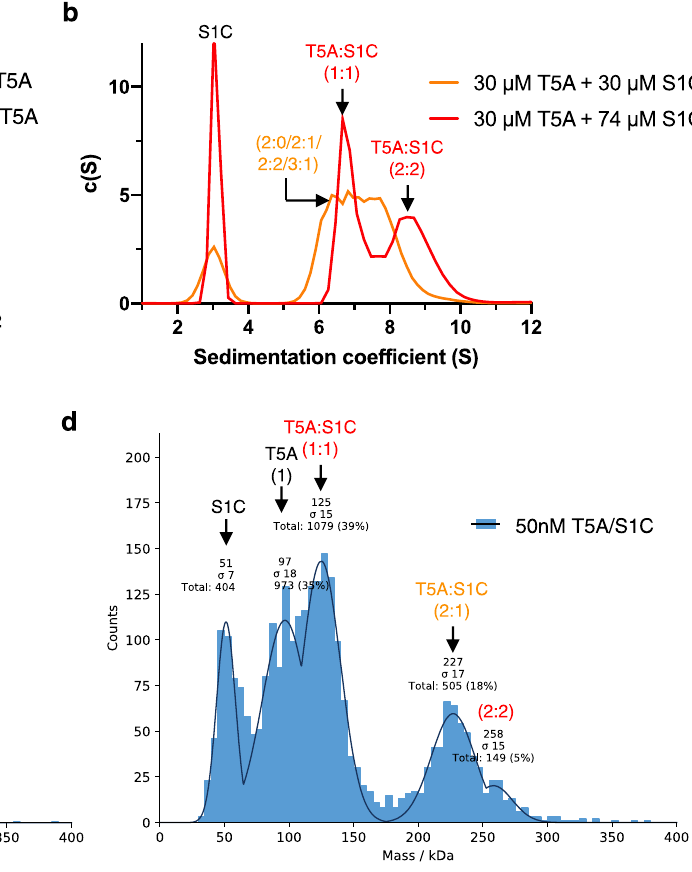
( a – b ). Mass photometry ( c – d ) reveals the concentration-dependent